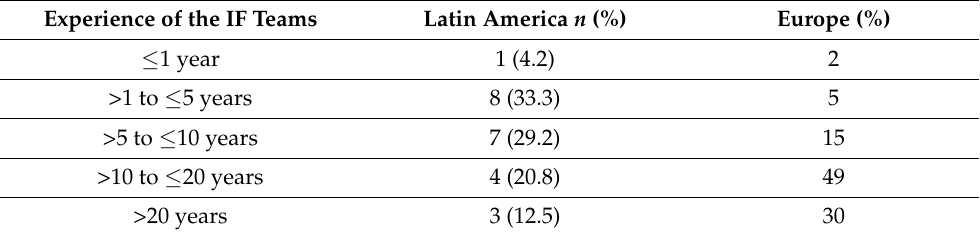
Table 1. Experience of the IF teams in Latin America and Europe [4].